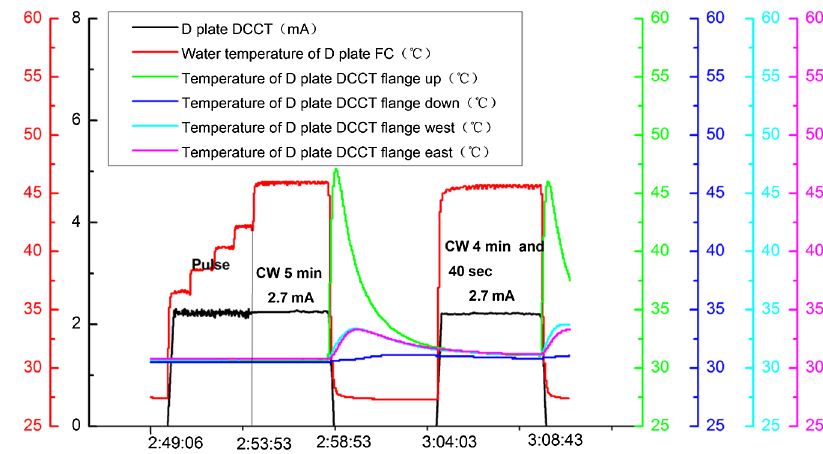
FIG. 17. Two times of CW beam operation at 2.7 Fig. 16. Inside the CM6, there are six HWR superconduct- ing cavities, six superconducting solenoids, and six BPMs